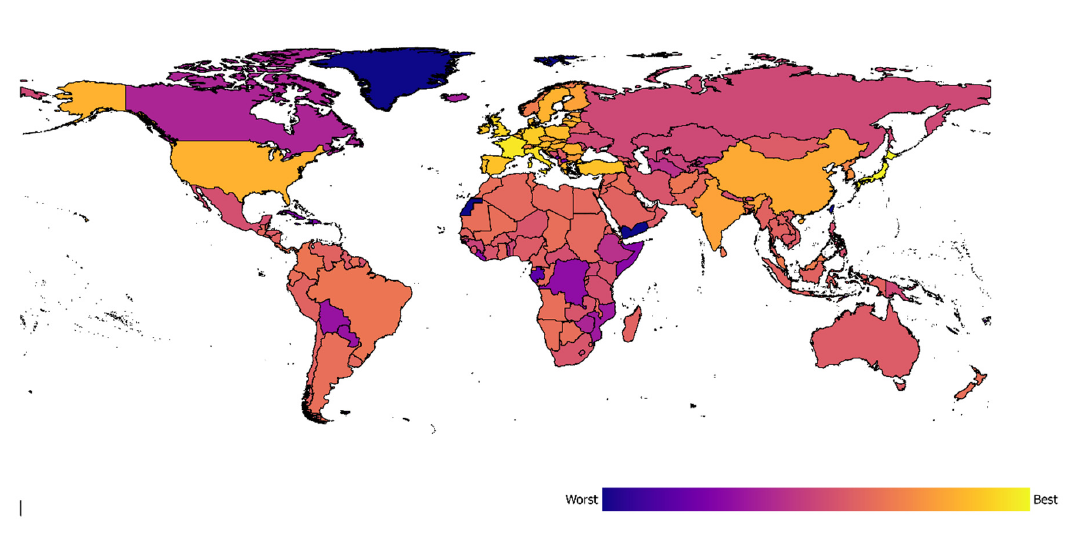
Figure 6. Global view on the technology and efficiency dimension.